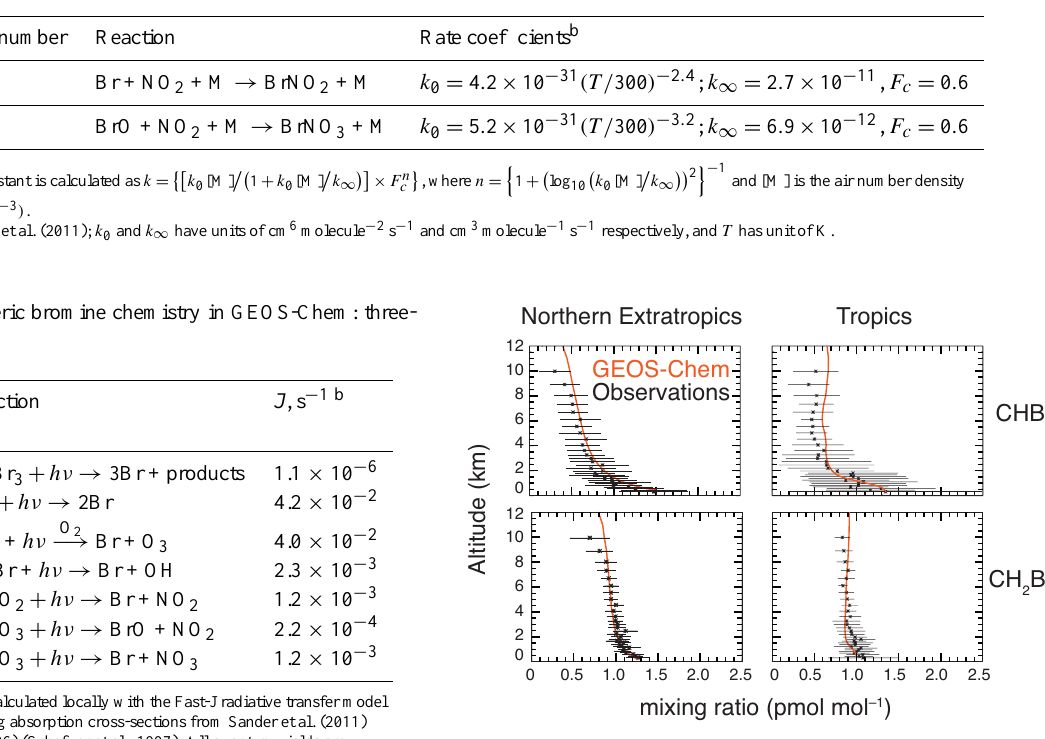
Fig. 1. Mean vertical profiles of CHBr 3 and CH 2 Br 2 concentra- tions in the northern extratropics (latitudes > 30 ◦ N) and tropics (30 ◦ S–30 ◦ N) for April–June. GEOS-Chem model results (in red) are compared to observations from NASA aircraft campaigns (in black) including TRACE-P, INTEX-B, and ARCTAS. See Liang et al. (2010) for references on the aircraft observations. Vertical pro- files have been averaged over coherent regions for individual mis- sions and then averaged again over the latitudinal domain. Horizon- tal bars are standard deviations in the original